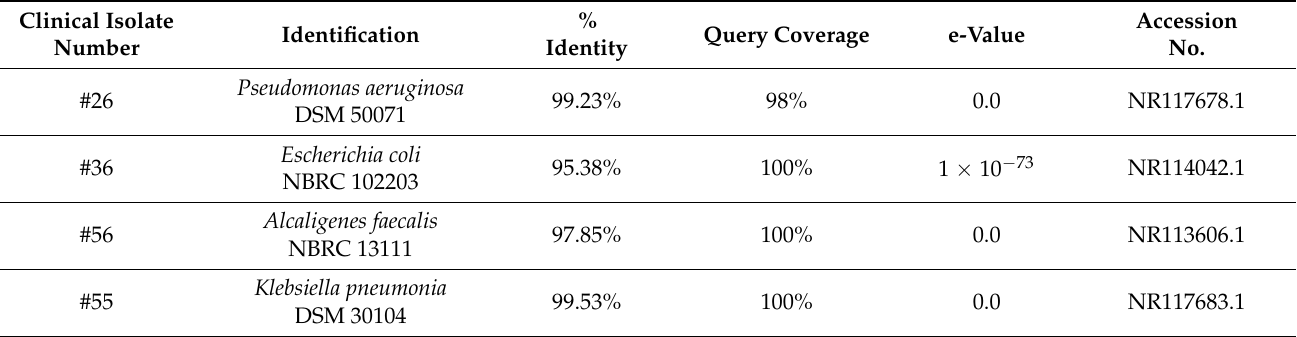
Table 2. Molecular identification of the selected six strong biofilm-forming isolates using 16S rRNA